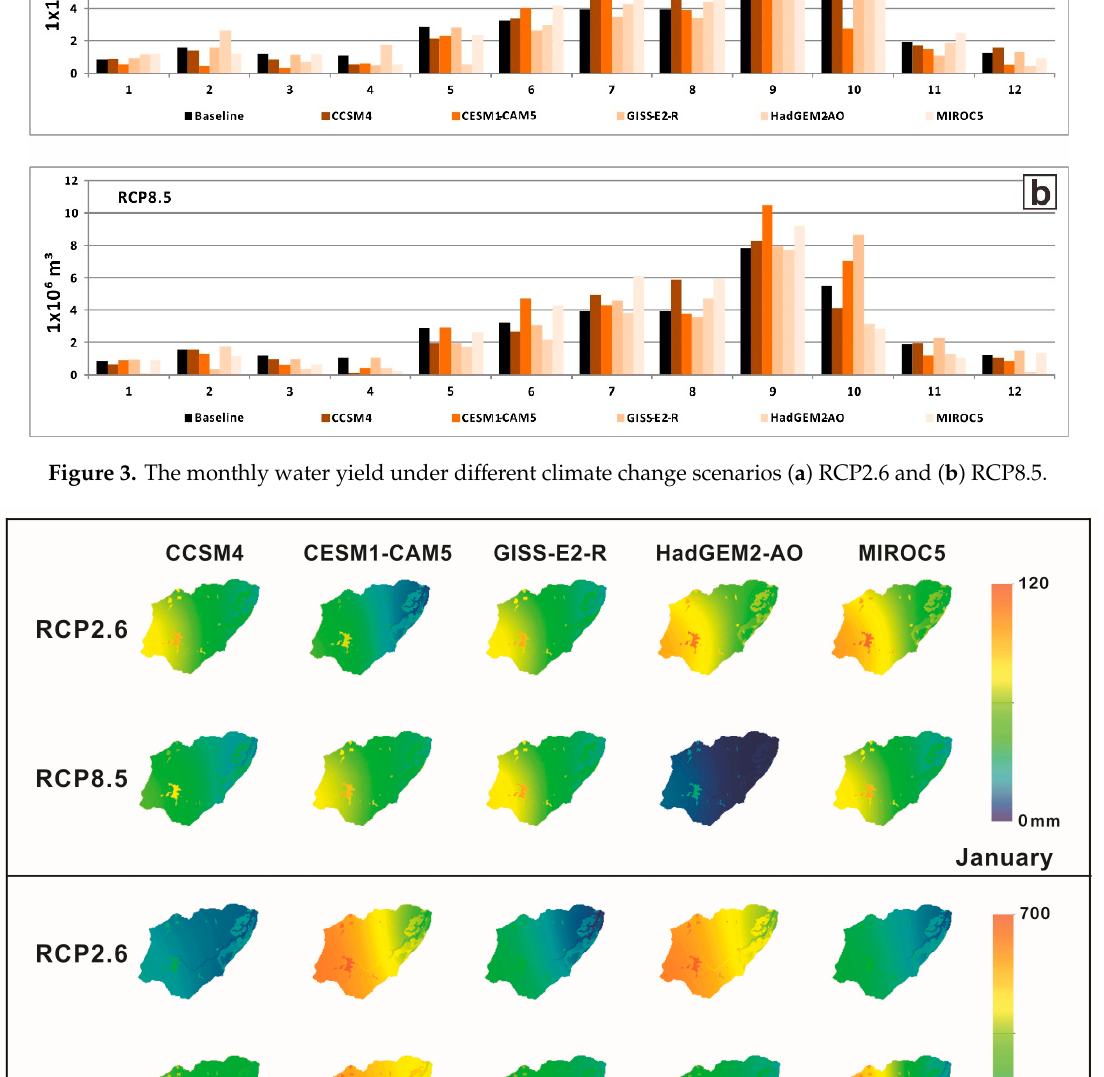
Figure 4. Spatial distribution of water yield in January and September.